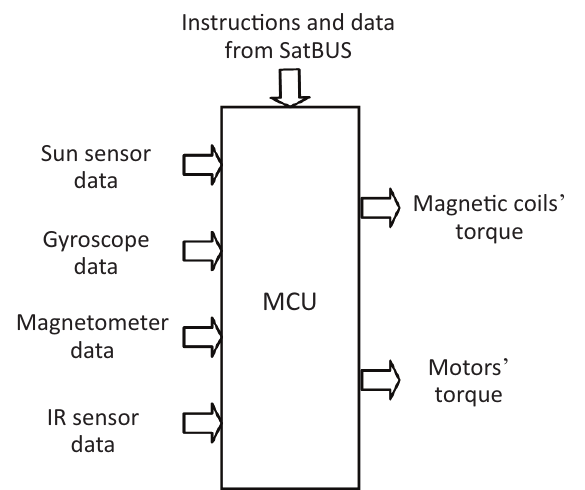
Fig. 4. Basic control model of the developed